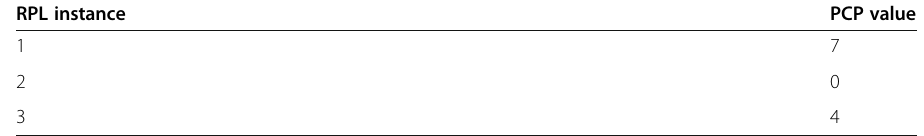
Table 2 Mapping between RPL instances and their corresponding PCP value RPL instance